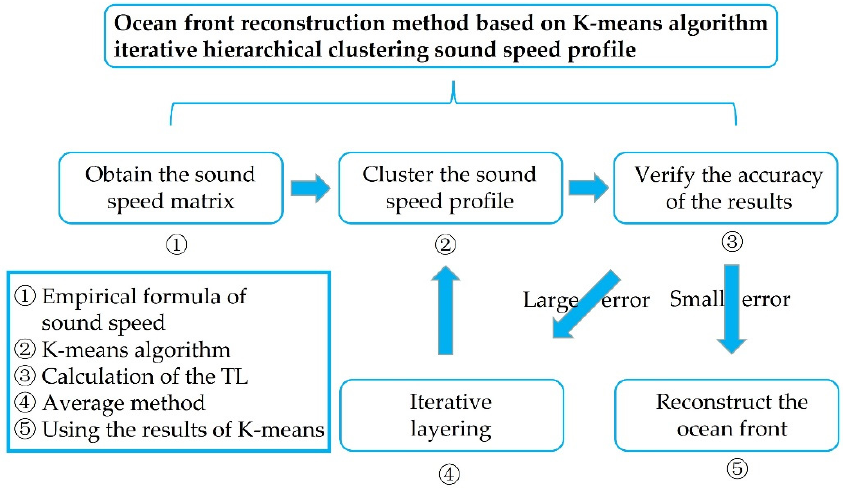
Figure 2. The technical route of the research process.